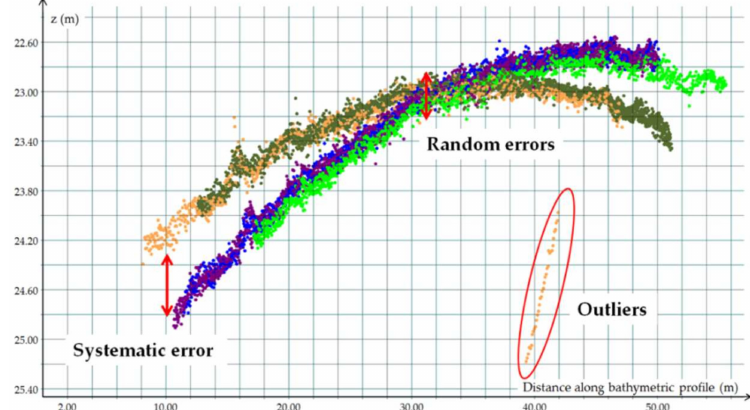
Figure 4. The three types of errors depicted through a bathymetric subset. Soundings are colored according to swath lines. Bathymetric data were acquired during a boresight calibration survey in Brest harbor using a Kongsberg / SIMRAD EM2040C